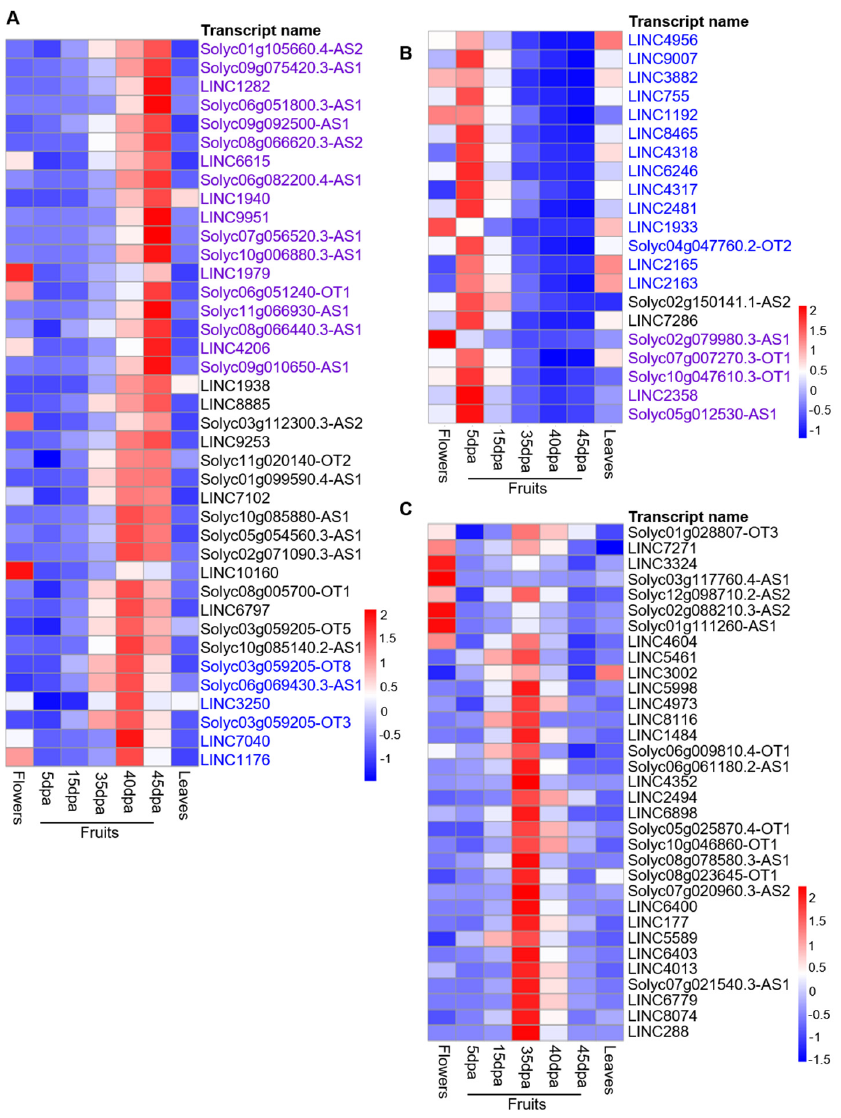
Figure 5. Expression levels of lncRNAs showing specific patterns during the expansion and ripening of fruits. ( A , B ) Heatmap representation of expression levels of lncRNAs consistently increased ( A ), and consistently decreased ( B ) in fruits from 5 dpa to 40 dpa. The names of lncRNAs marked with purple indicates whose expression were increased in 45 dpa fruits compared to 40 dpa fruits. The names marked with black indicates no changes, and with blue indicated the expression levels were decreased in 45 dpa fruits compared to 40 dpa fruits. ( C ) Heatmap representation of the subset lncRNAs whose expression levels were consistently increased to reach the peak at 35 dpa and then consistently decreased in fruits from 35dpa to 45 dpa. All the lncRNAs are selected based on the foldchange more than 2 in the comparison between the two adjact developmental stages. The levels of lncRNAs in flowers and leaves were displayed as the control.